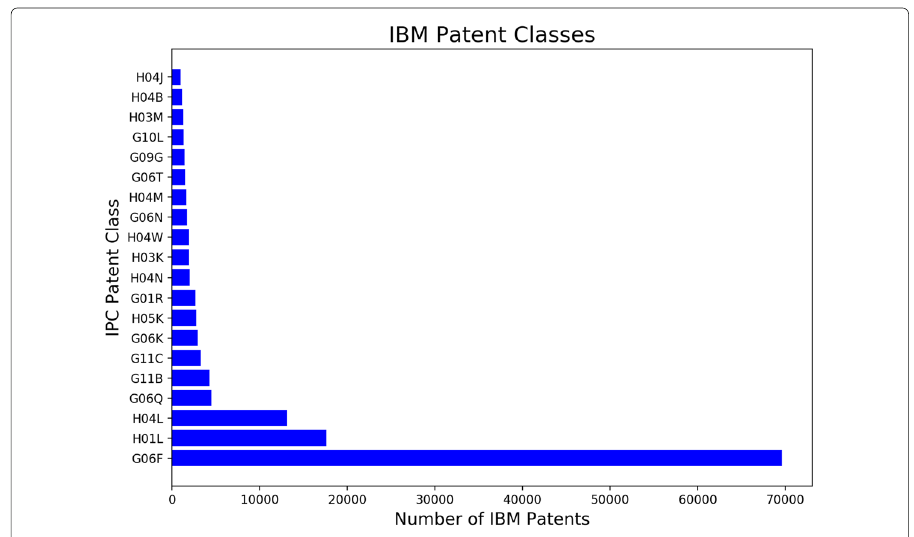
Fig. 2 Distribution of IBM Patent Classes (Cooperative Patent